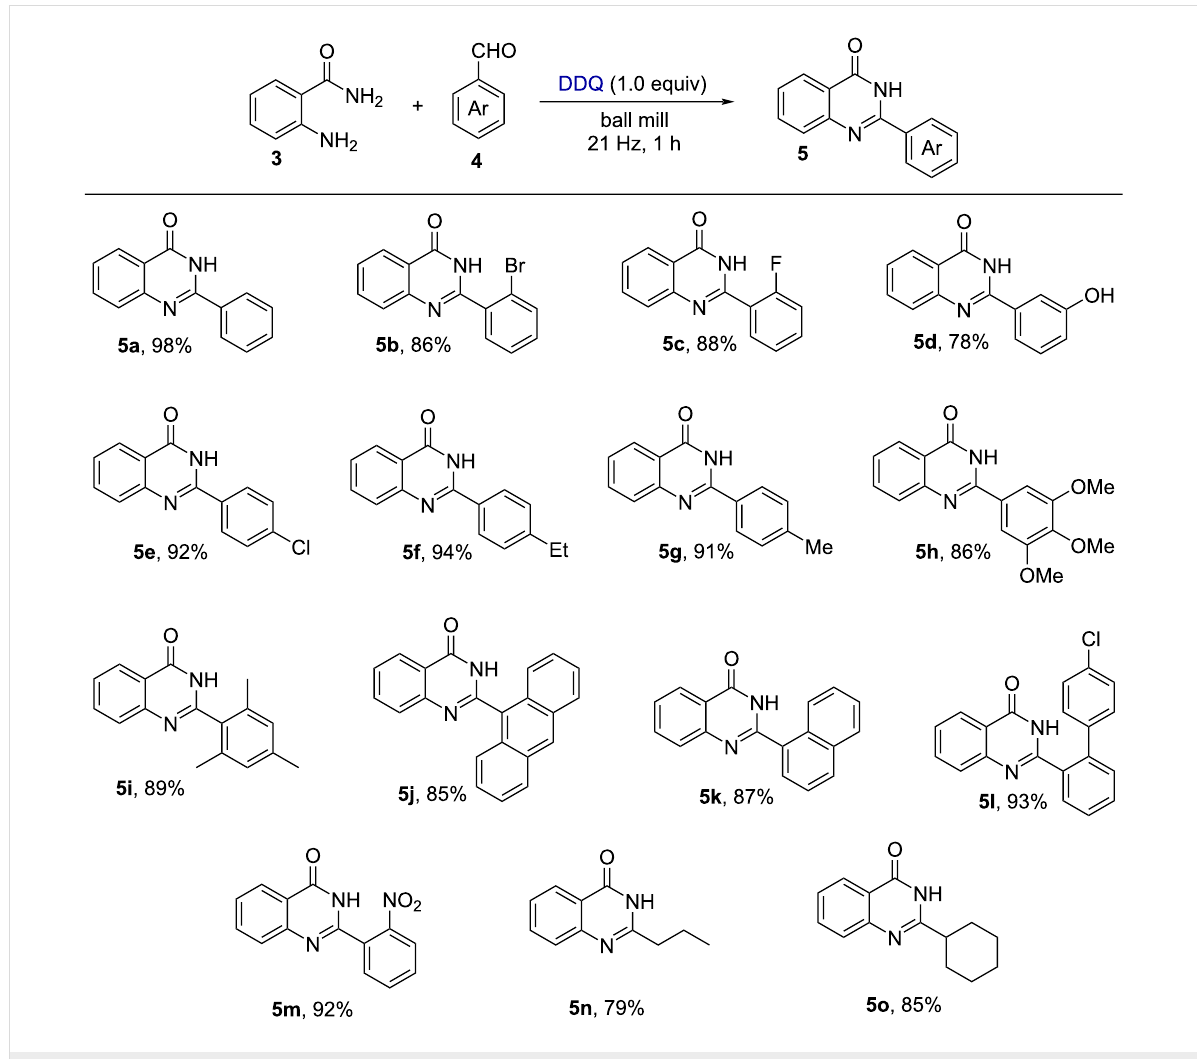
Figure 3: Synthesis of quinazolin-4(3 H )-one derivatives.